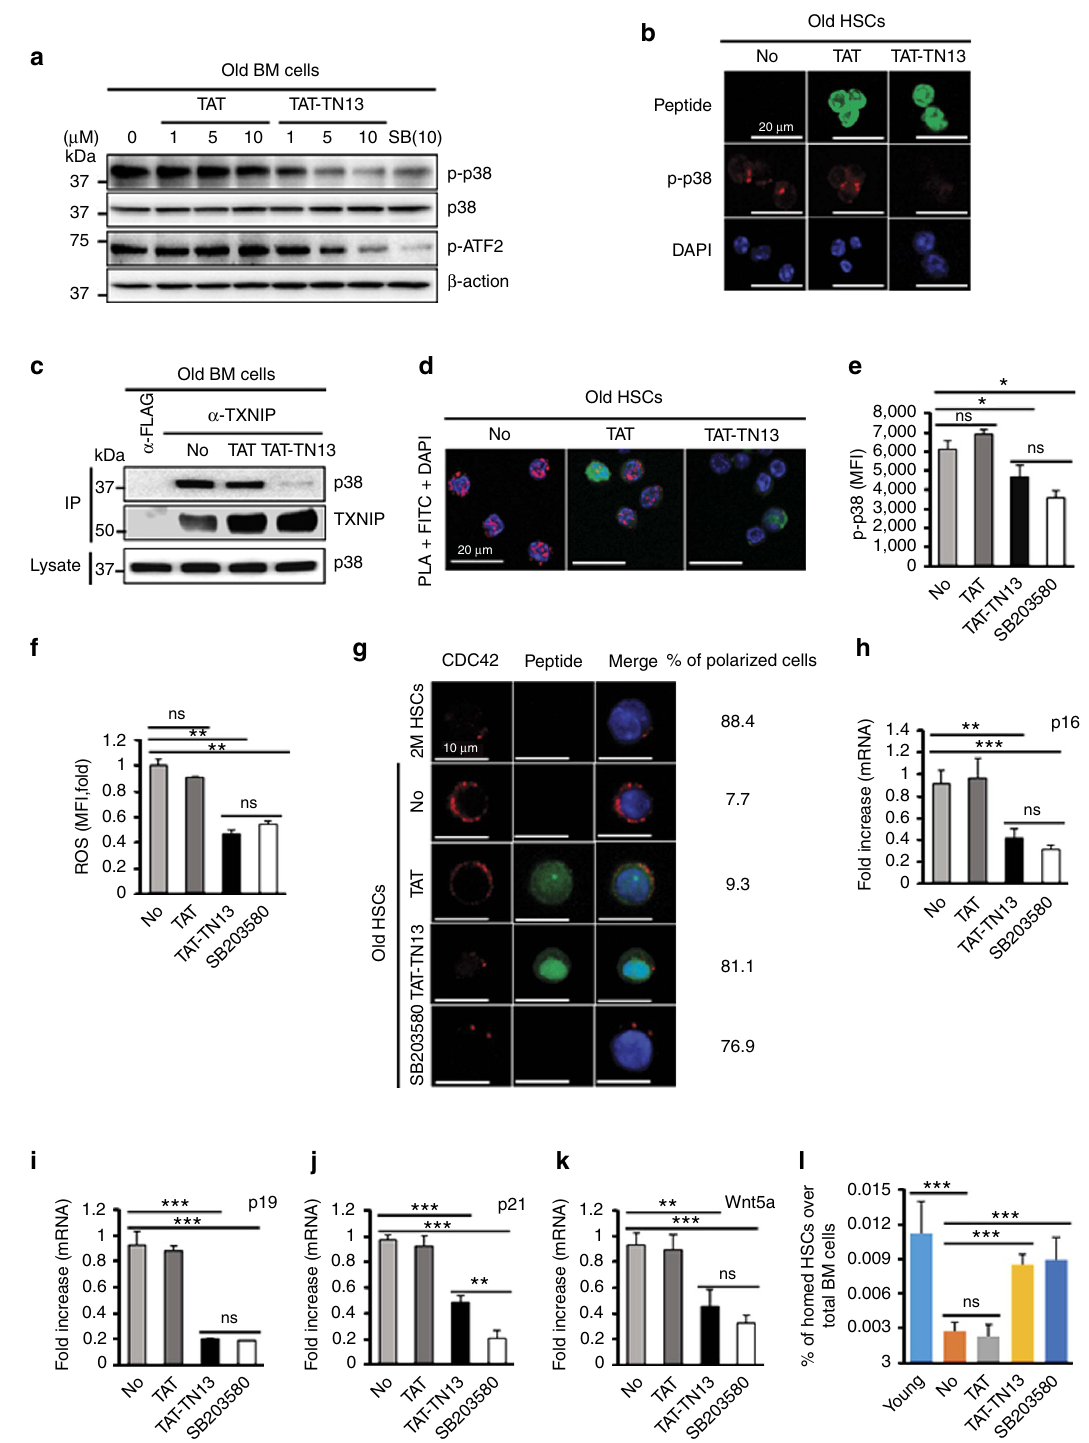
Figure 4 | TXNIP-derived peptide (TAT-TN13) inhibits p38 activity and rejuvenates aged HSCs in vitro. ( a ) Phosphorylation of p38 and ATF2 in old